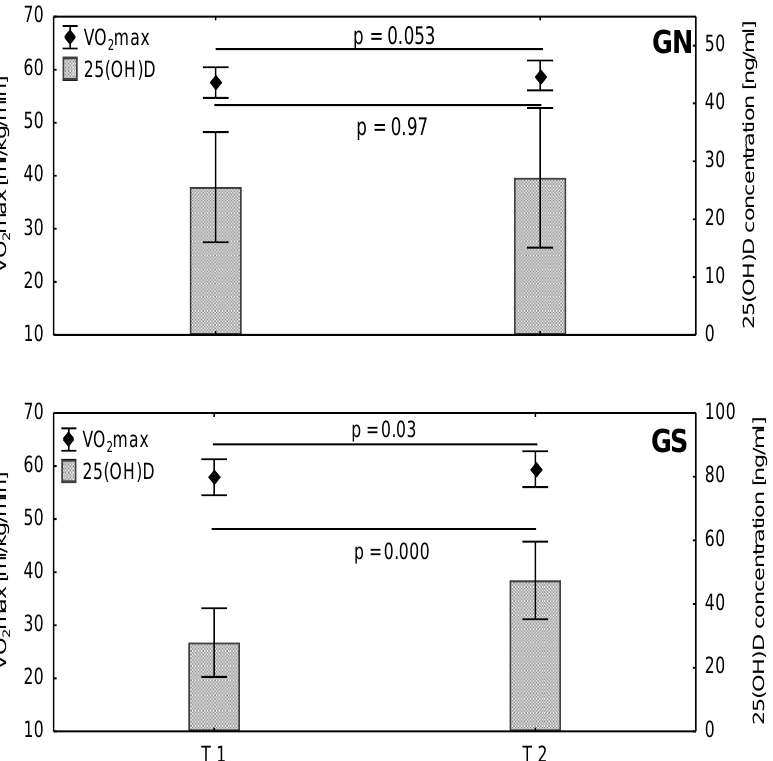
Figure 1. Changes of maximal oxygen uptake (VO2max) and 25(OH)D concentration during the experimental period in the non-supplemented group (GN) and the supplemented group (GS).